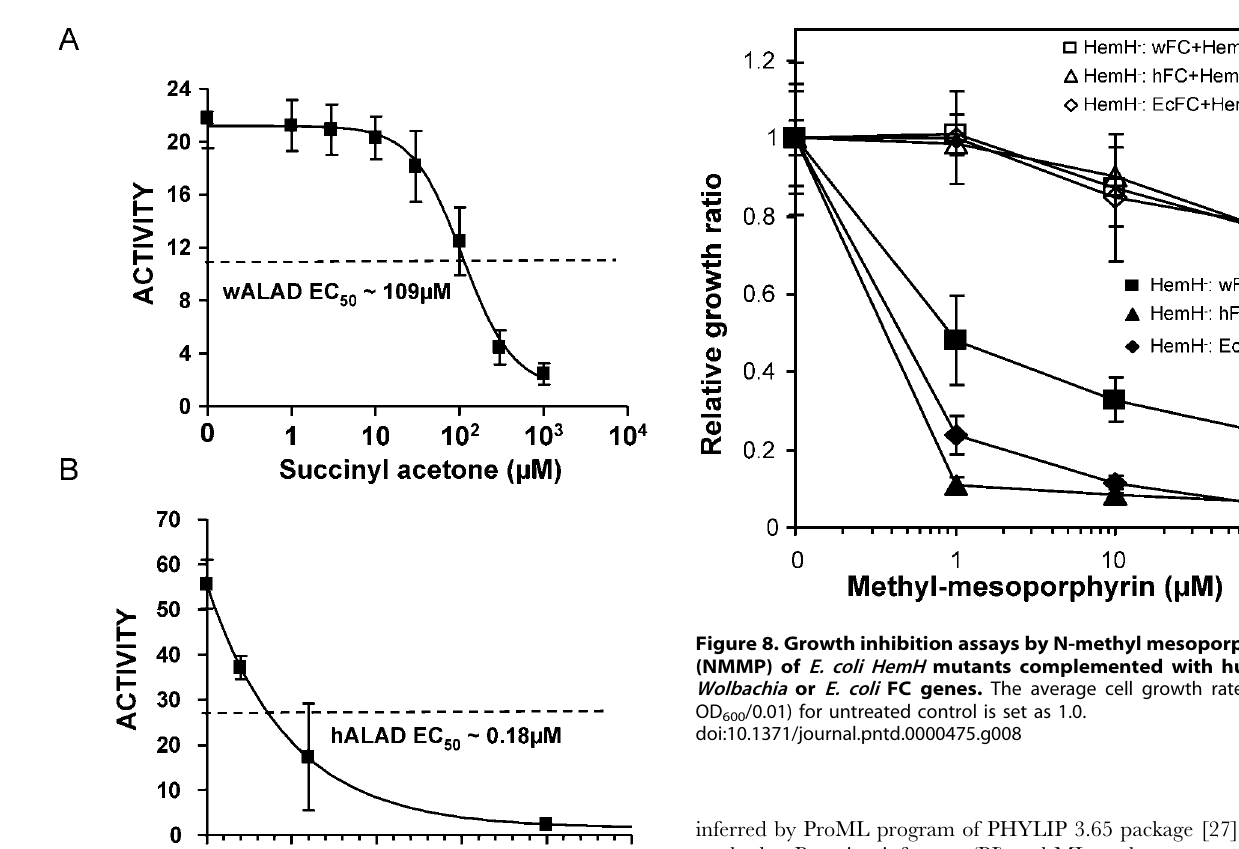
Figure S2 The Vmax and Km of the purified recombinant wALAD and hALAD enzymes. A) wALAD and B) hALAD were assayed at pH 8.0 and 7.0, respectively. The enzyme activity is expressed as m mol PBG/mg of protein/h. Table S1 Wolbachia , human and E. coli heme gene specific primers were used for acquiring the full-length coding sequence by polymerase chain reaction (PCR) amplification, and were subsequently cloned into pET21a + vector. Primers were designed according to information acquired from available B. malayi , Wolbachia ( w Bm), human and E. coli genome databases. Restriction enzyme sites in primers are underlined. Abbreviations used: w: Wolbachia , h: human, Ec: E. coli , f: forward primer, r: reverse primer. The full names of the abbreviations for the heme biosynthetic enzymes are listed in the caption of Figure 1. Found at: doi:10.1371/journal.pntd.0000475.s003 (1.77 MB TIF)